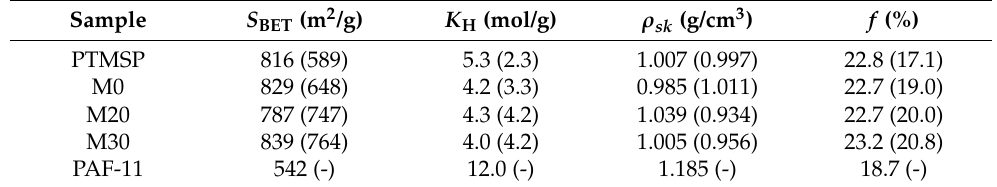
Table 3. The parameters of PTMSP-based films from N 2 adsorption isotherms: apparent BET surface area (SBET)and the Henry constant ( K H ). The skeletal density ( ρ sk ) and calculated free-volume fraction ( f ) are also presented. The results for the porous aromatic framework PAF-11 are also presented. The parameters after CO 2 exposure are shown in the